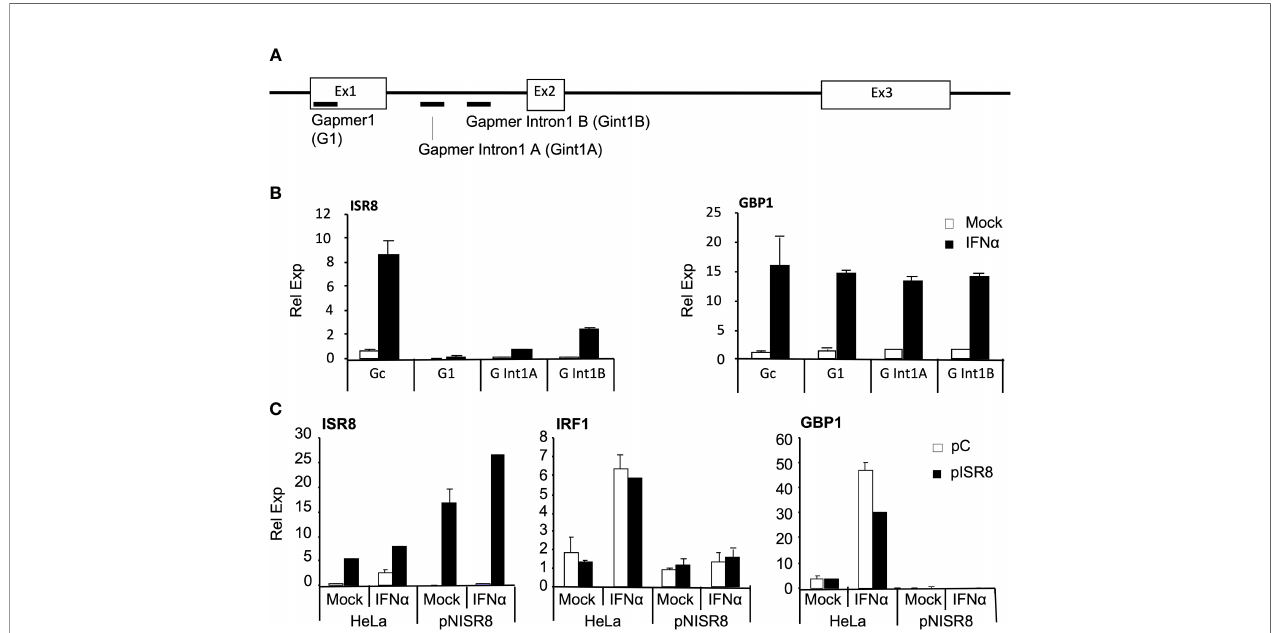
FIGURE 3 | Analysis of ISG induction after transient inhibition or overexpression of ISR8. (A) Schematic of gapmer binding to ISR8 sequences. (B) ISR8 and GBP1 mRNA levels in HeLa cells transfected with control (Gc) or ISR8 gapmers for 48 h and treated with 0 or 1000 U/ml IFN a for 6h. (C) ISR8, IRF1 and GBP1 mRNA levels in the indicated cells transfected with a control plasmid (pC) or pCAGGS-ISR8 (pISR8) for 48 h and treated with 0 or 1000 U/ml IFN a for 6h. GAPDH mRNA was also evaluated and used as a reference. Error bars indicate standard deviations. Experiments were performed at least four times and a representative fi gure is